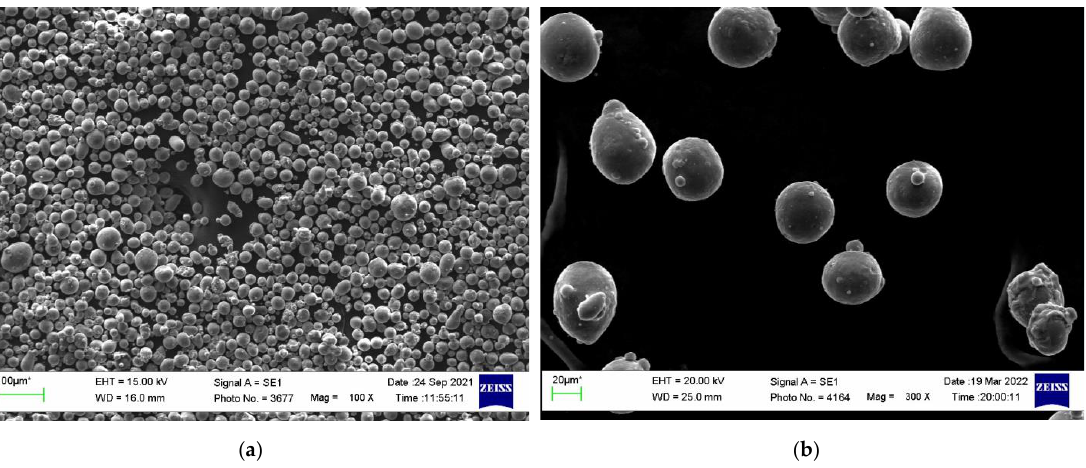
Figure 2. The numerical simulation of VHCF system with a half of aluminum specimen ( a ) and ( b ) results of resonant frequency drop for hot-rolled aluminum specimens. The mechanical properties of the hot-rolled and SLM aluminum alloys are given in the Table 1. The hot-rolled aluminum alloy has a slightly higher ultimate tensile strength compared to SLM material. The mass density is almost the same for both alloys. Table 1. Mechanical properties of D16T and AlSi10Mg aluminum alloys. Material Density, kg/m 3 Young’s Module, GPa UTS, MPa Elongation, % Hot-rolled D16T 2790 74 390 9 SLM AlSi10Mg 2700 72 370 7 The quality of the final SLM product is depending on the quality of initial powder, laser scanning parameters and strategy [16]. The particles of AlSi10Mg aluminum alloy were primary investigated on SEM (Figure 3).